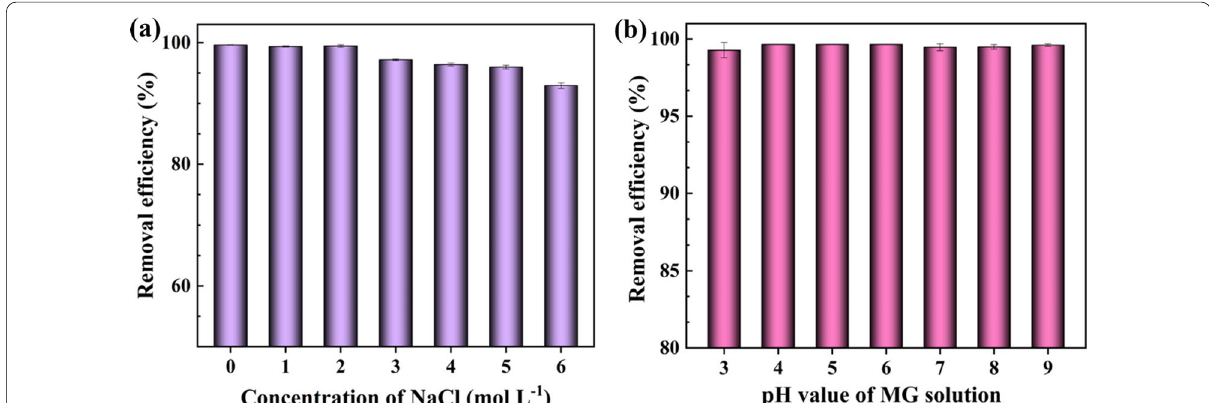
Fig. 6 Effects of ionic strength ( a ) and pH ( b ) on the removal efficiency of the ZIF-67/cotton fibers towards MG (adsorption conditions: mass of adsorbent, 10 mg; initial dye concentration, 100 mg/L; volume of dye solution, 20